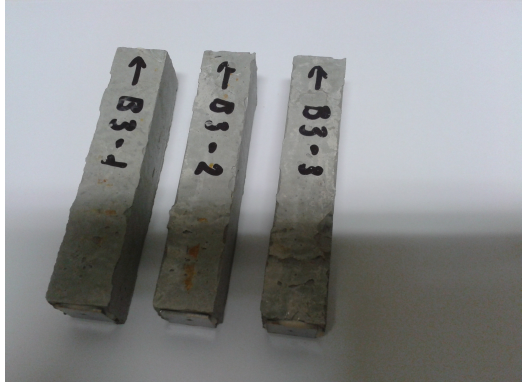
Figure 3. Used prismatic